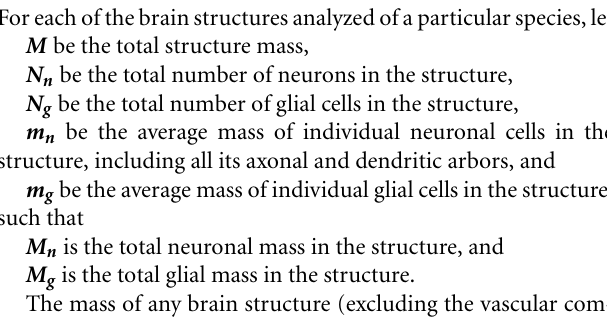
FIGURE 1 | Variation in structure mass as a function of number of neurons and glial cells in the structure. Average brain structure mass for each species is plotted as a function of its total number of neurons (A) and non-neuronal (glial) cells (B) . Structure mass is given in picograms. Power functions are plotted separately for cerebral cortex (circles), cerebellum (squares) and rest of brain (triangles) in eulipotyphlans (orange), primates (red) and rodents (green). Power function constants and exponents are listed in Table 1 . The two graphs are plotted with identical scales for comparison. Notice that the power functions are overlapping in (B) , but not in (A) . Data from Herculano-Houzel et al. (2006, 2007, 2011), Azevedo et al. (2009), Sarko et al. (2009), and Gabi et al.